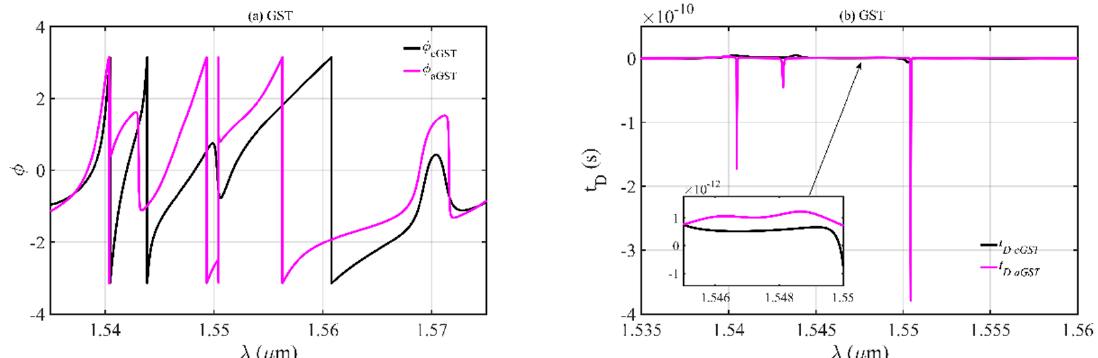
Figure 9. ( a ) Phase Φ and ( b ) group delay t D of Sagnac ring coupled 1 × 3 MOMRs with GST.